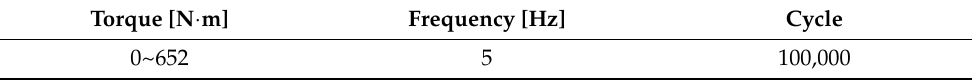
Figure 5. ( a ) Schematic of the gear durability test; ( b ) Gear durability tester.